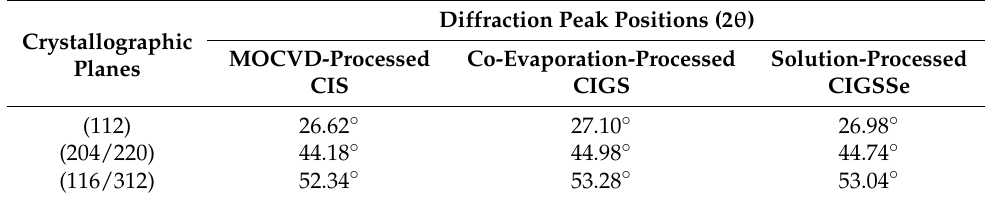
Figure 2. Three main XRD peaks of chalcopyrite crystal structure: ( a ) (112) peak; ( b ) (204/220) peak; ( c ) (116/312) peak. Table 1. Diffraction-peak positions of various types of chalcopyrite structure samples.